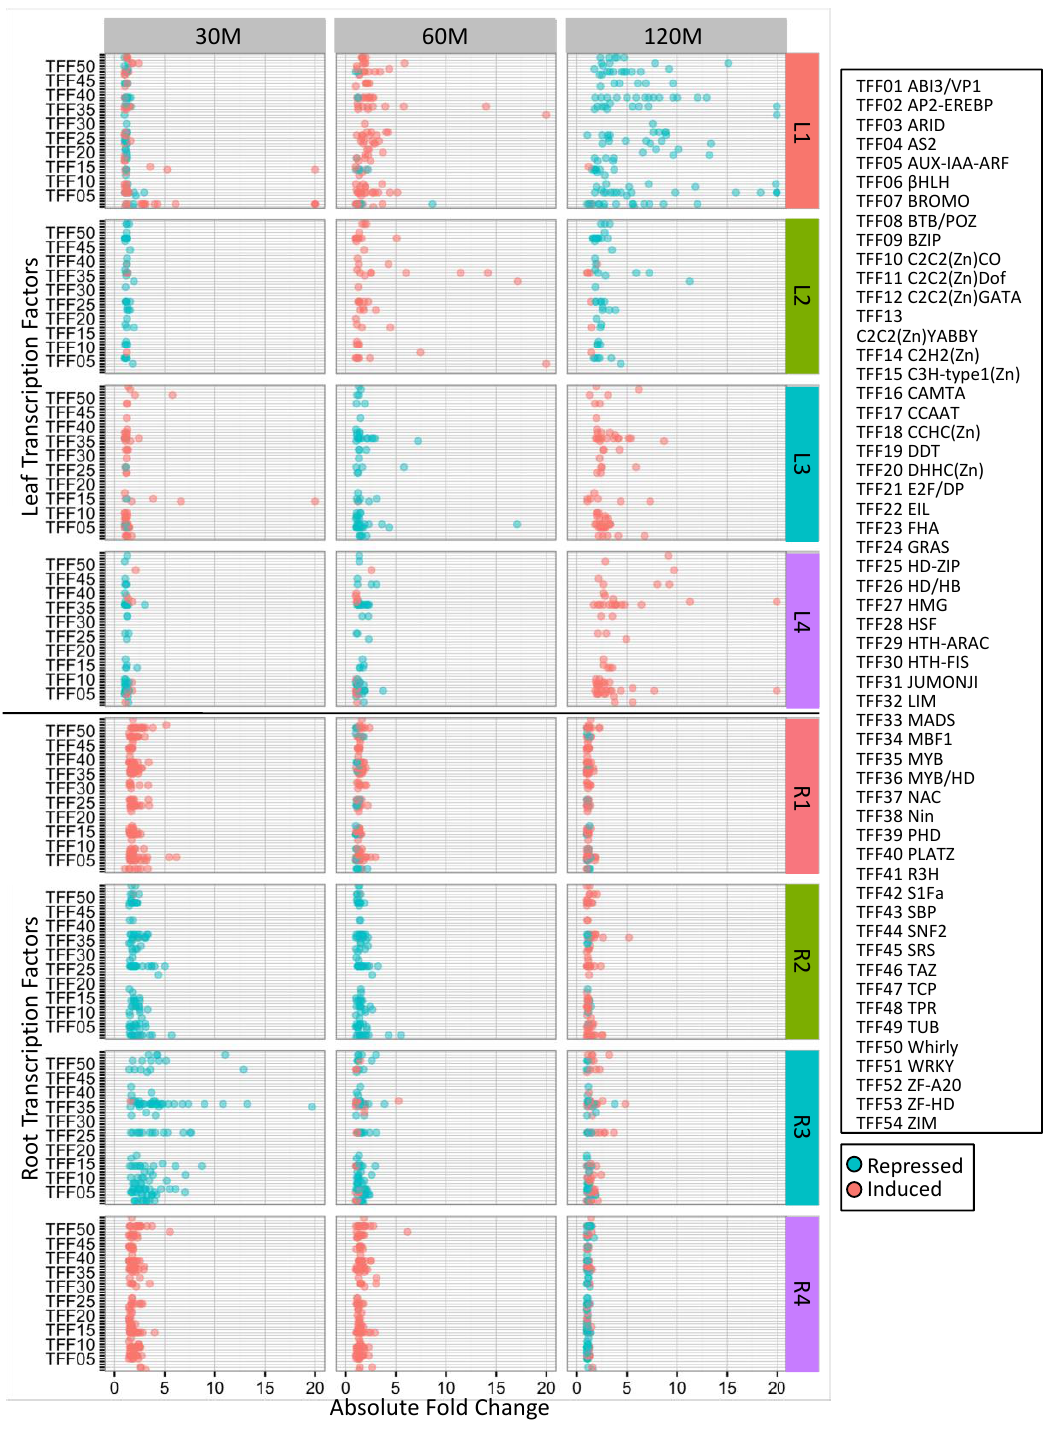
Figure 4. Distinct groups of transcription factors (TFs) can be associated with each iron stress responsive expression cluster. We plotted absolute fold change for each differentially expressed transcription factor by transcription factor family (TFF) within each expression cluster at each time point (Supplemental Table S11). Fold change was limited to a maximum cutoff of 20. Cluster numbers, order and color are the same as in Figure 2. Each dot represents a single transcription factor. Red dots are transcription factors induced by iron stress, while blue dots are transcription factors repressed by iron stress.